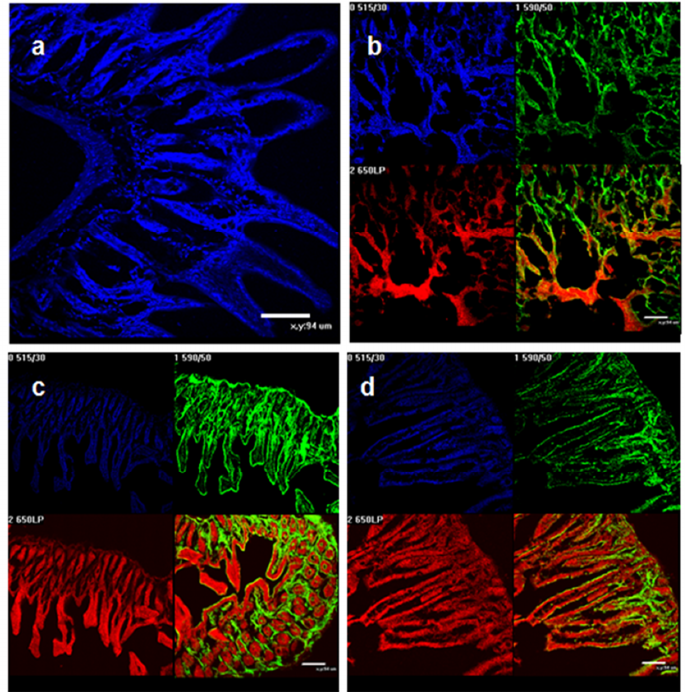
Figure 5. Dynamics of furano-allocolchicinoid 2 preparation accumulation in different tissues. Mice were once IV injected with a comparable quantity of formulations. Percentage of rhodamine B per gram of tissue (%/g) in liver ( a ), spleen ( b ), lungs ( c ), and kidney ( d ) at different time post injection. Significant differences ( p < 0.05) are shown by brackets.